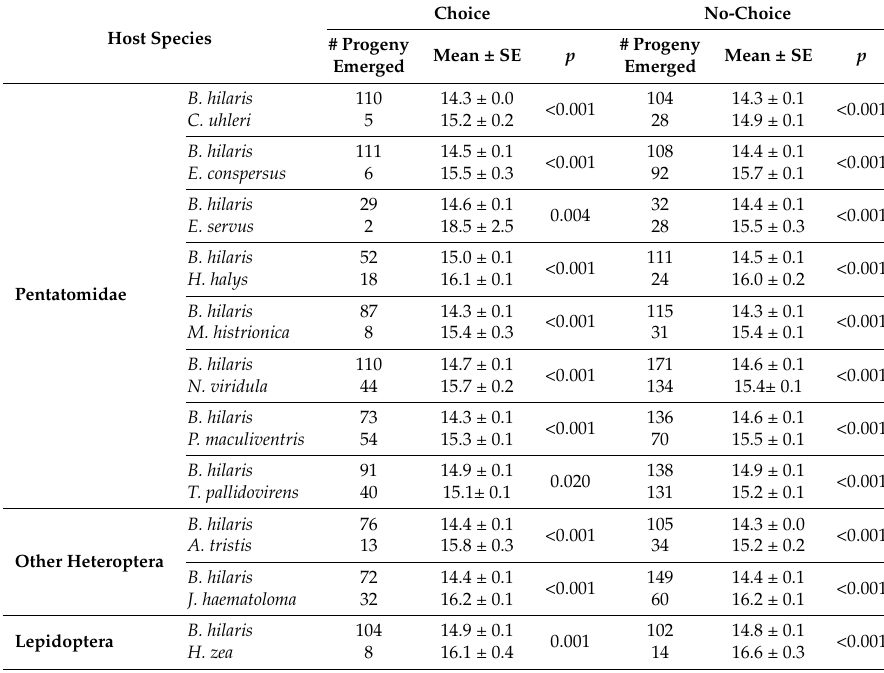
Figure 1. Mean ( ± SE) days of first emergence of Ooencyrtus mirus adults from Bagrada hilaris versus alternate hosts in choice and no-choice tests. N is the number of replicates. Means for the pairs with “ns” (non-significant) did not differ significantly (Wilcoxon–Mann–Whitney test, p > 0.05). Table 5. Mean ( ± SE) developmental time (in days) from egg to adult of Ooencyrtus mirus in choice and no-choice